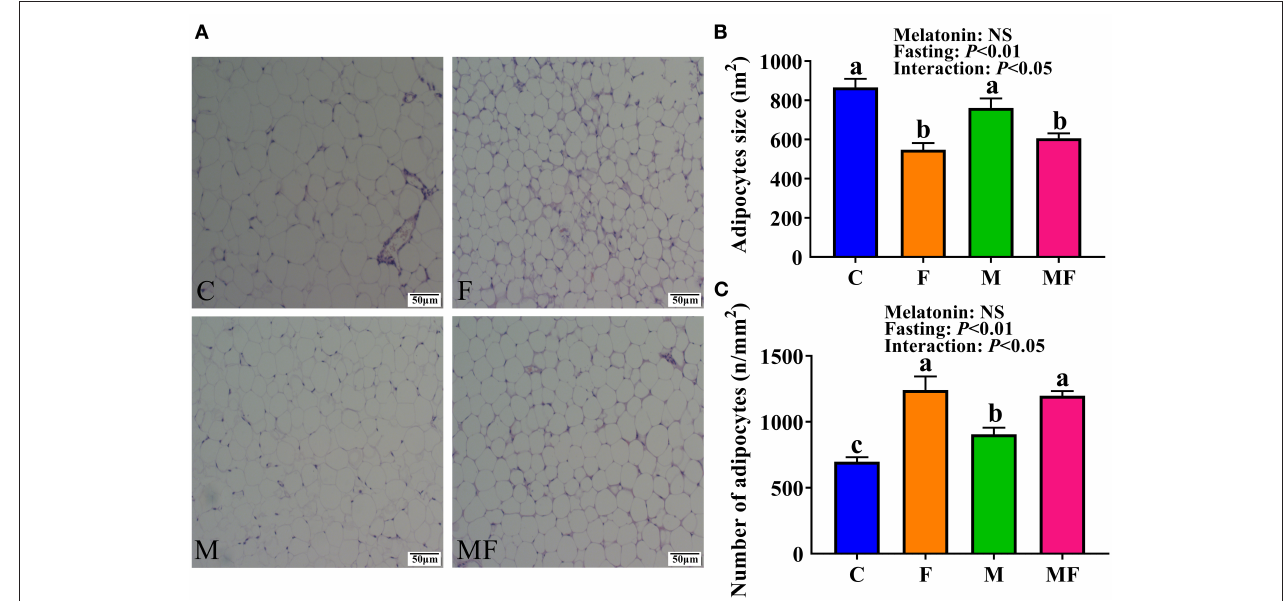
FIGURE 3 | The effects of intermittent fasting and melatonin supplementation on adipocytes morphology in mice. (A) Representative H&E staining of epididymal WAT sections. Scale bar: 50 µ m; (B) quantification of adipocyte size; (C) quantification of adipocyte number per square millimeter. Data are presented as mean ± SEM, n = 6. Labeled means without a common letter differ ( P < 0.05), NS: P ≥ 0.05. C, control; F, intermittent fasting; M, melatonin; MF, intermittent fasting plus melatonin. The C and M mice were fed ad libitum , while the F and MF groups underwent alternative-day feed deprivation. The M and MF groups mice were supplemented with melatonin at a dose of 10 mg/kg body weight by drinking.